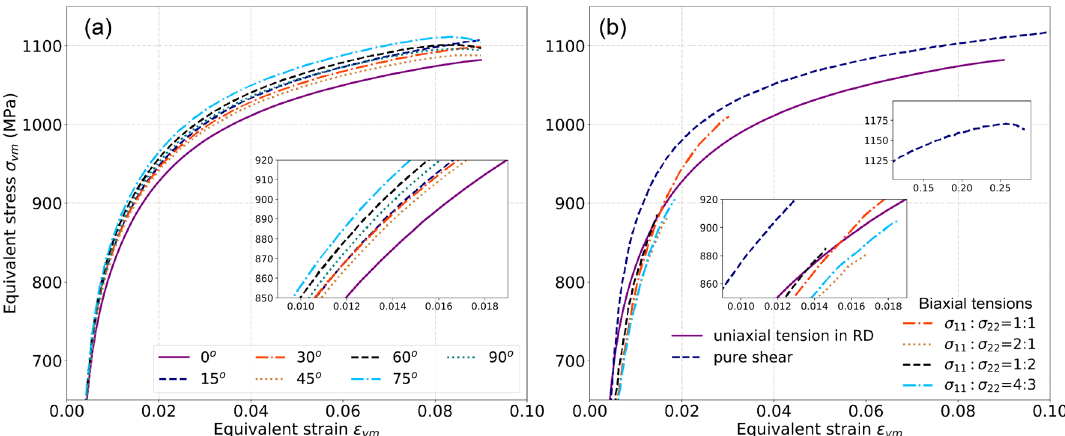
Figure 5. Flow stress curves of ( a ) uniaxial tension (UT) in different directions and ( b ) pure shear and biaxial tension with different stress ratios. σ 11 : σ 22 represents the stress ratio of the normal stresses in RD and TD.